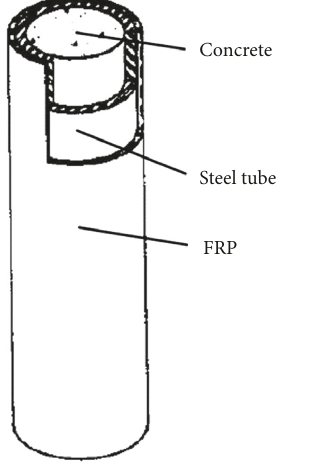
Figure 1: Concrete-filled steel tube confined with